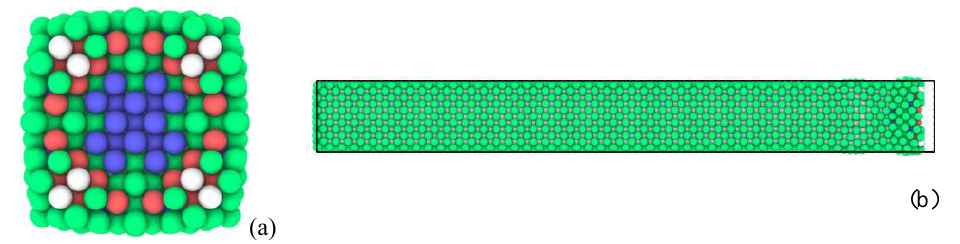
Fig. 18. (а) Cut of the initially perfect nanorod by the plane perpendicular to the X axis within 5 Å from the right edge at the time instant 2 ps. Green shows the surface atoms and other structureless ones; white shows the atoms forming the FCC lattice; blue shows the atoms forming the BCC lattice; red shows the atoms forming the FCCP lattice. (b) Outlook of the nanorod in plane XZ, black line – the whole system size, the cut area is to the right within 5 Å from the right edge.